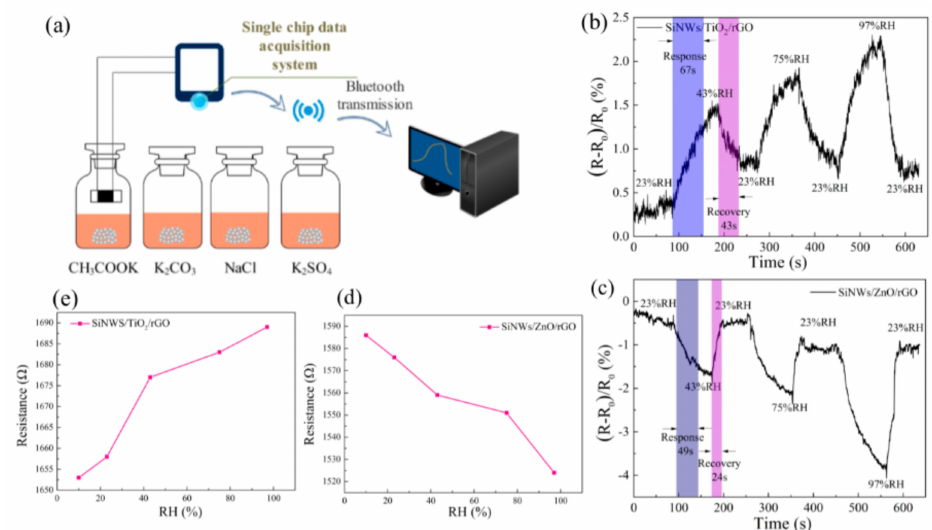
Figure 3. ( a ) Schematic diagram of the humidity sensing experimental setup; ( b )–( c ) the response curves of the two types of sensors to four levels of humidity; ( d )–( e ) the resistance of the two sensors as a function of